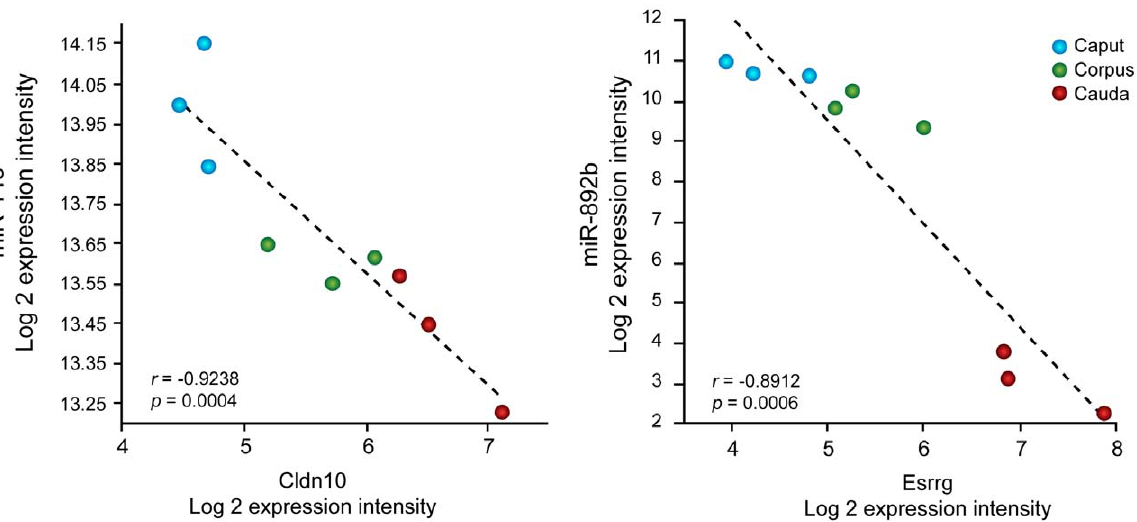
Figure 6. Correlation between the expression of Cldn10 and Esrrg with the expression of miR-145 and miR-892b. Correlation was based on the mRNA and miRNA expression intensities detected in three epididymal segments (Caput, corpus or cauda) from three donors. Each dot represents the Log 2 intensity from one segment of one donor.